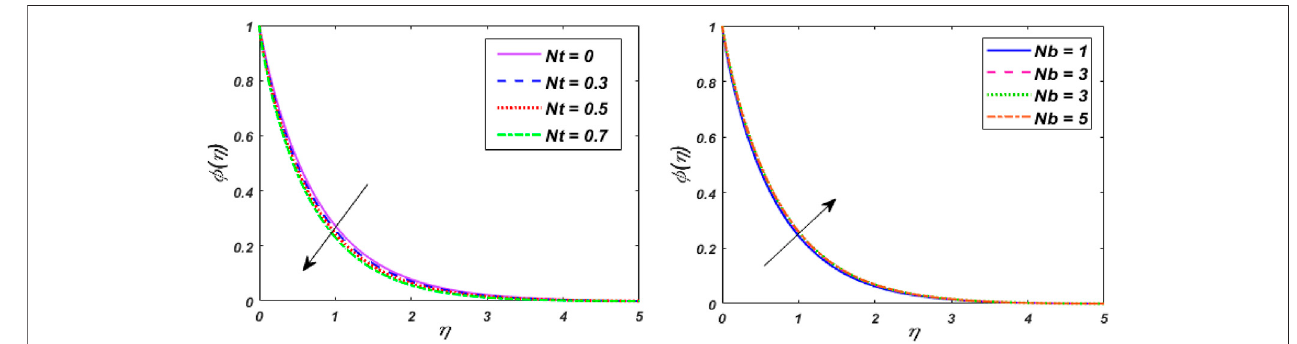
FIGURE 11 | Nt and Nb against ϕ ( η ) .